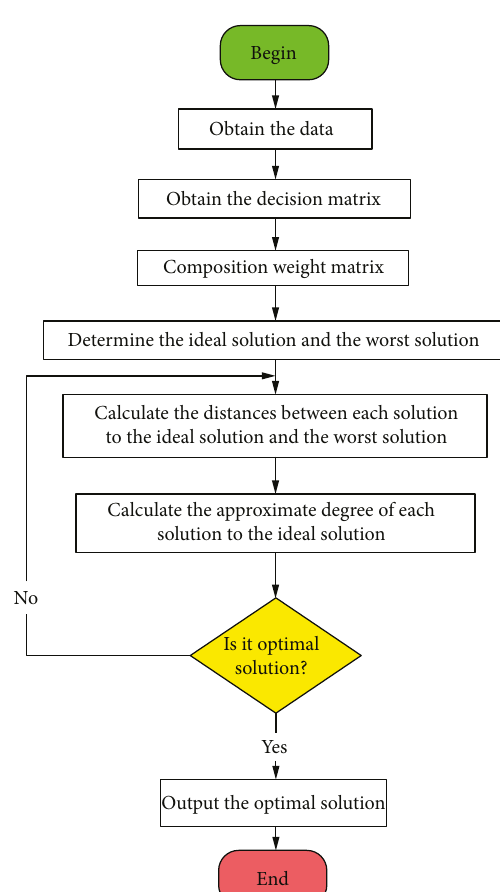
Figure 3: The fl ow chart of TOPSIS